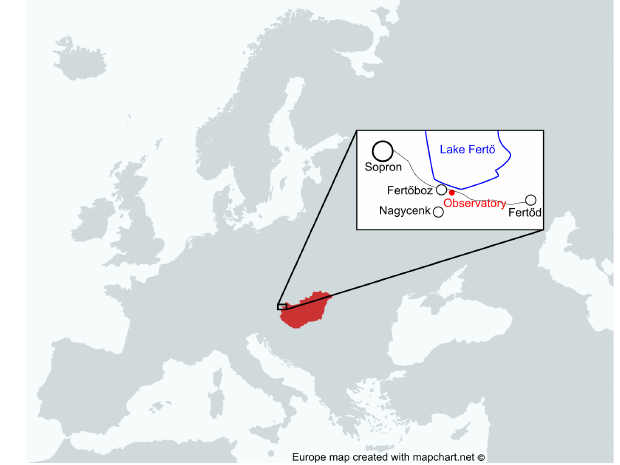
Figure 1. Location of the NCK observatory.